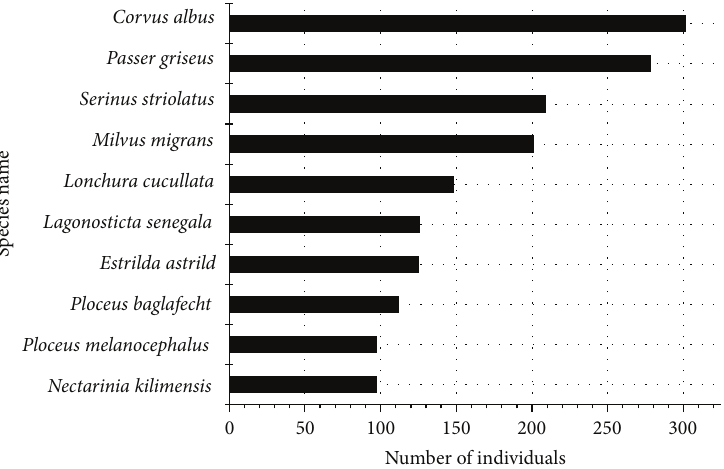
Figure 7: Top ten most represented bird species in all sites of Musanze city.